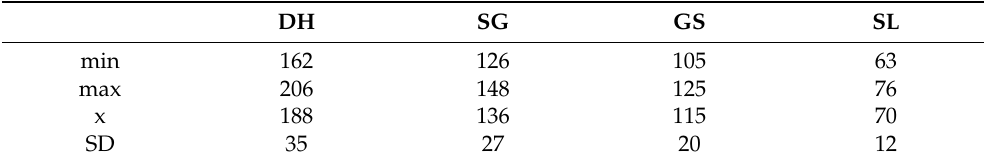
Table 3. Values of the load factor for individual courses (own calculations based on the Giovanis method [6]) and dimensionless quantities.